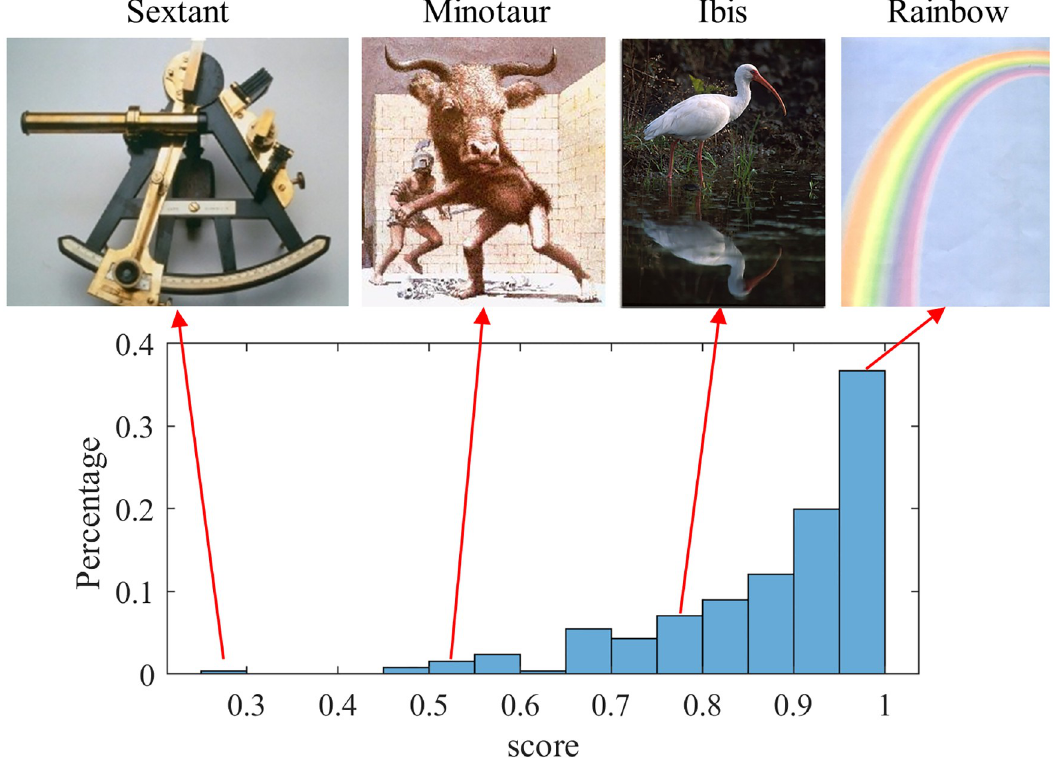
Fig 2. Image naming task: Distribution of average scores for different images. We provide examples of images that appear simple and challenging.